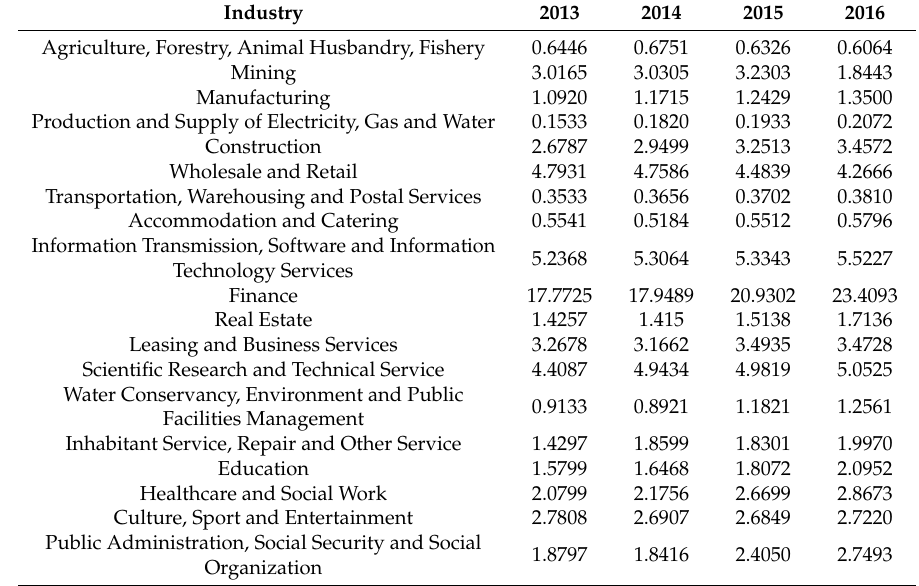
Table 6. The carbon productivities of 19 industries in Beijing (2013–2016) (unit: 10,000 yuan per ton).